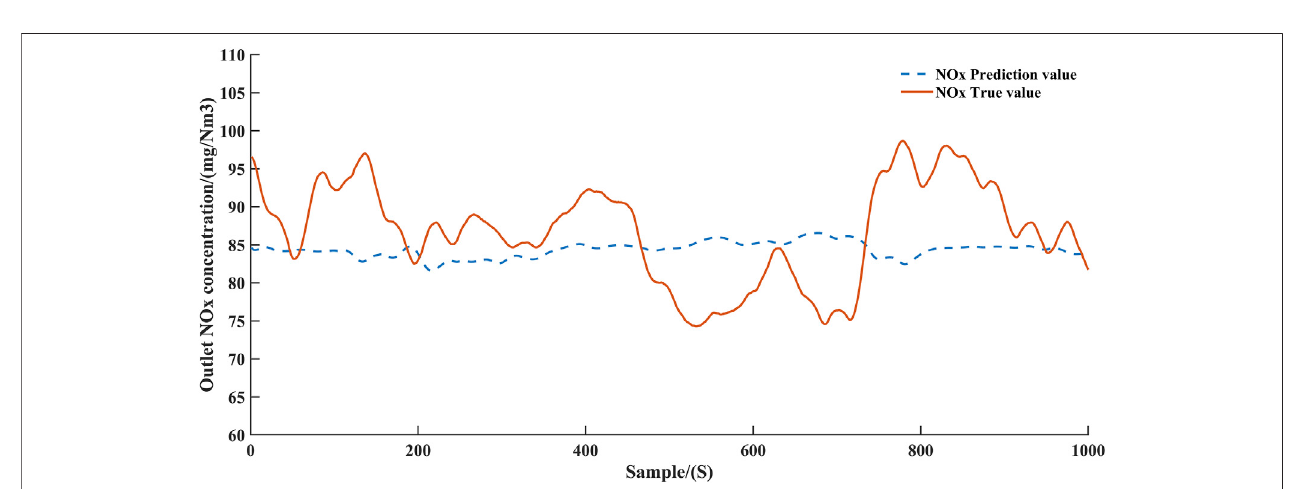
FIGURE 6 | NOx concentration prediction